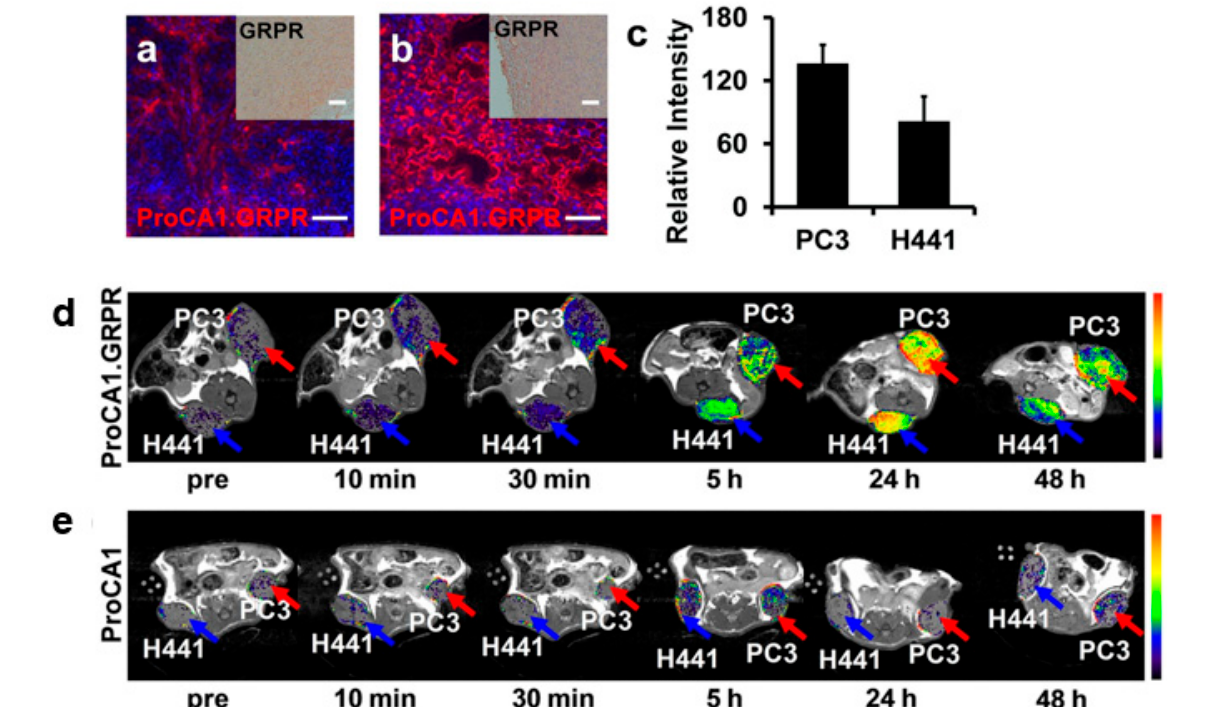
Figure 1. ProCA1.GRPR distribution and gastrin-releasing receptor (GRPR) expression in xenografted tumor tissue from Pu et al. 2015 (modified); ( a , b ) Immunofluorescence staining of ProCA1.GRPR targeting GRPR on ( a ) H441 and ( b ) PC3 tumors in xenograft mice. Blue: nucleus staining. Red: Staining GRPR on ( a ) H441 and ( b ) PC3 tumor. ( c ) Graphical representation of fluorescence intensity of ProCA1.GRPR staining in PC3 and H441 tumors. PC3 tumor shows a stronger expression as H441 tumors. ( d ) T1-weighted spin echo MR imaging of ProCA1.GRPR targeting GRPR in H441 (blue arrow) and PC3 (red arrow) in mice (xenograft). ( e ) T1-weighted spin echo MR imaging of non-targeted ProCA1 in H441 (blue arrow) and PC3 (red arrow) in mice (xenograft). Scale bar = 100 µm. Colorbars show the signal intensity (from high (red) to low (black)).